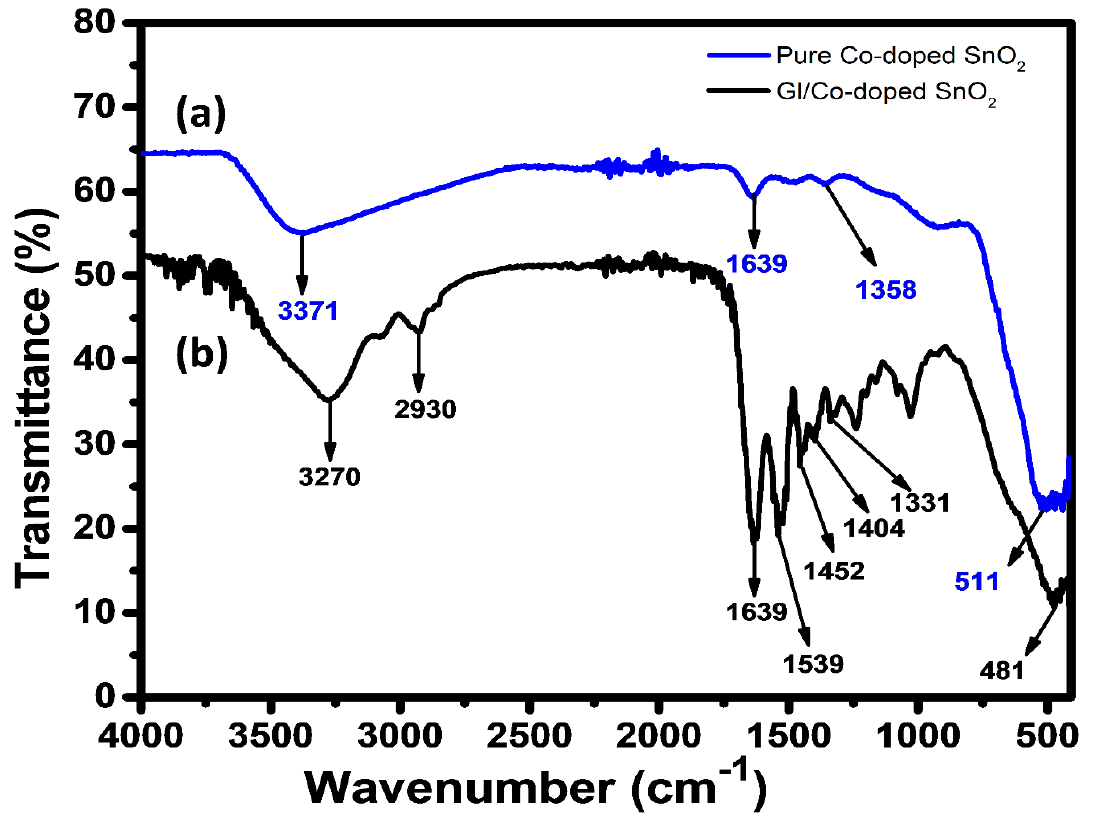
Figure 4. FTIR spectra of Co-SnO 2 nanomaterial ( a ) and GL/Co − SnO 2 hydrogel nanocomposite ( b ).